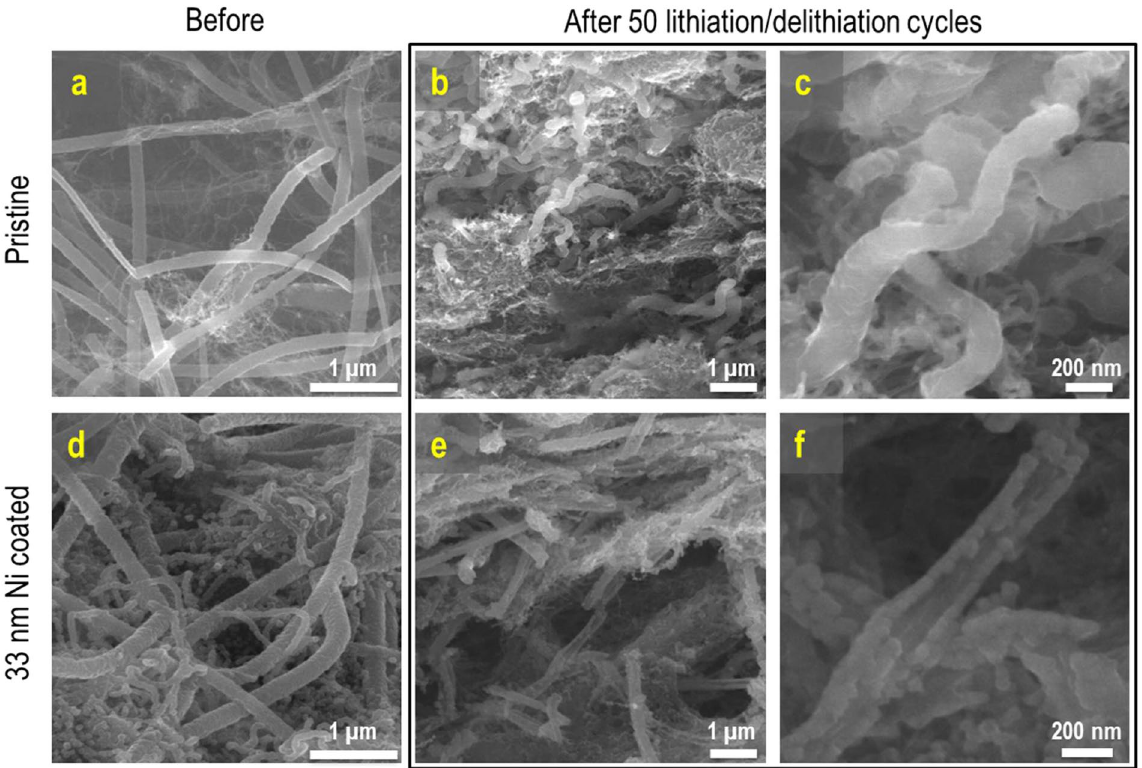
Figure 5. Post mortem analysis of the electrodes upon charge-discharge cycles. SEM images of pristine ( a ) and Ni-coated k-SiNWs assemblies ( d ). Morphology change after 50 lithiation/delithiation cycles: pristine ( b , c ) and Ni-coated ( e , f ) k-SiNWs assemblies. The Ni coating cracks upon Li insertion but the resulting configuration remains attractive, as it resembles the Si thin-film behavior. Si maintains an intimate contact